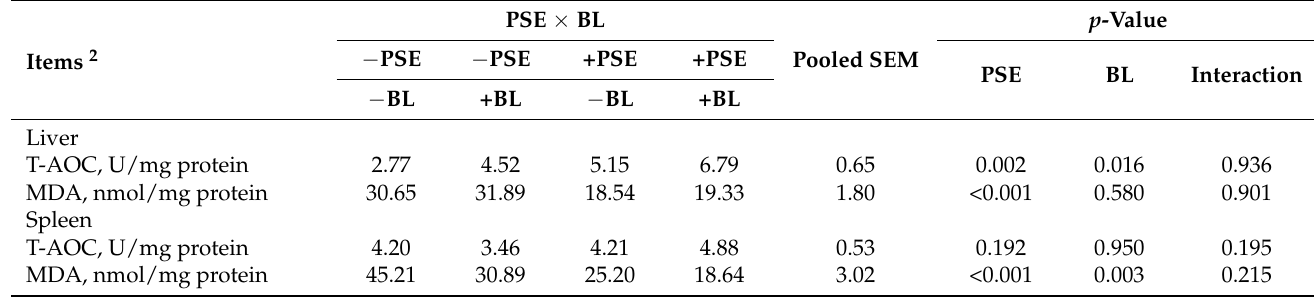
Table 8. Effects of BL and PSE on antioxidant indices of liver and spleen of weaned piglets 1 .